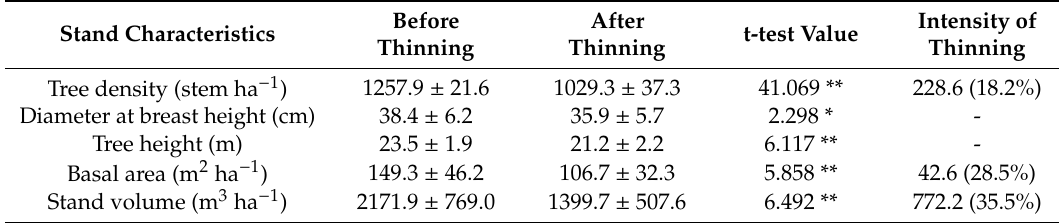
Table 1. Stand dendrometric characteristics (mean ± standard deviation (SD)) before and immediately after thinning operations (year: